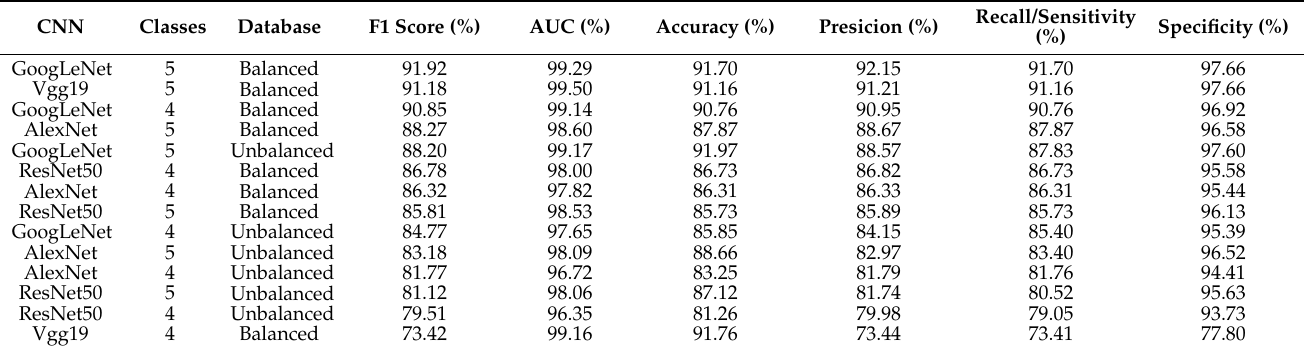
Table 4. Performance metrics for every pre-trained